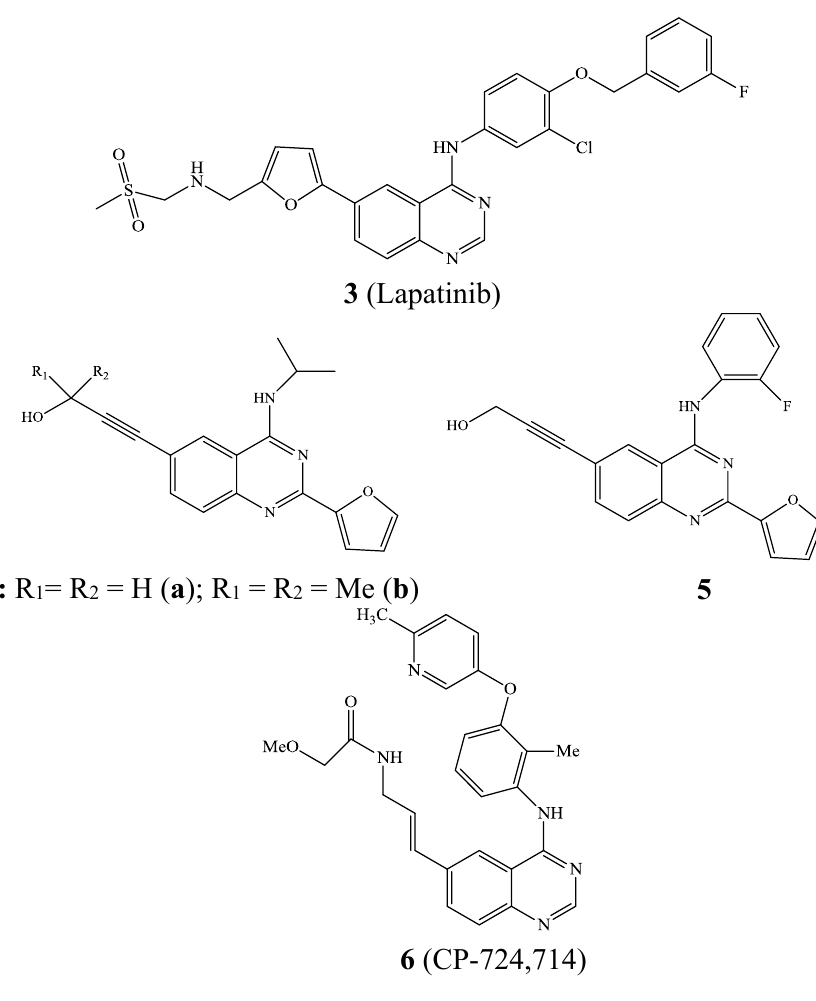
1 2 Lapatinib 3 , a 6-heteroaryl substituted 4-anilinoquinazoline derivative is an oral dual tyrosine kinase inhibitor (TKI) that targets both EGFR and HER2 to inhibit the proliferation of breast cancer cells [3]. The 6-alkynylated 4-aminoquinazolines 4 and 5 (Figure 2), on the other hand, serve as selective inhibitors of Aurora A [4]. Likewise, the 4-anilinoquinazoline derivative 6 (CP-724,714) is a selective ErbB2 angiogenesis inhibitor under investigation for the treatment of breast, ovarian and other types of cancer [5]. Figure 2. Carbo-substituted 4-(aryl/alkylamino)quinazolines of biological importance.